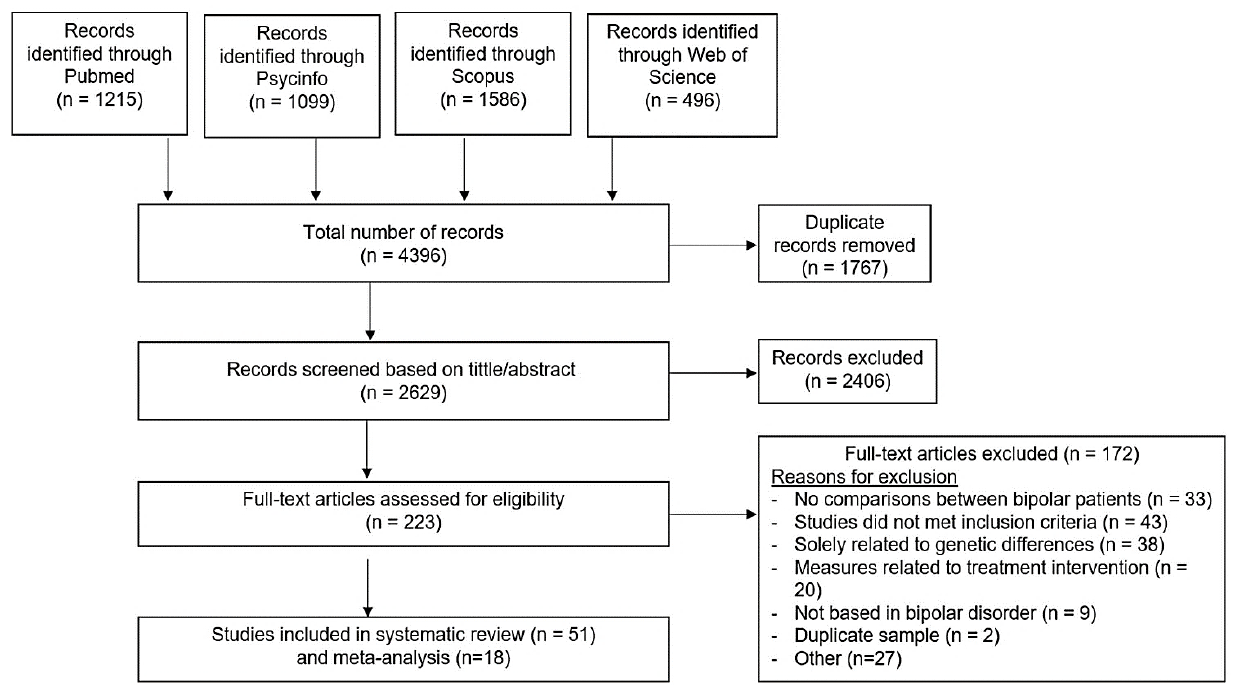
Figure 1. PRISMA (Preferred Reporting Items for Systematic reviews and Meta-analyses) diagram. Following exclusion criteria, a total of 51 studies were selected for systematic review. Among them, 18 articles were included for meta-analysis.